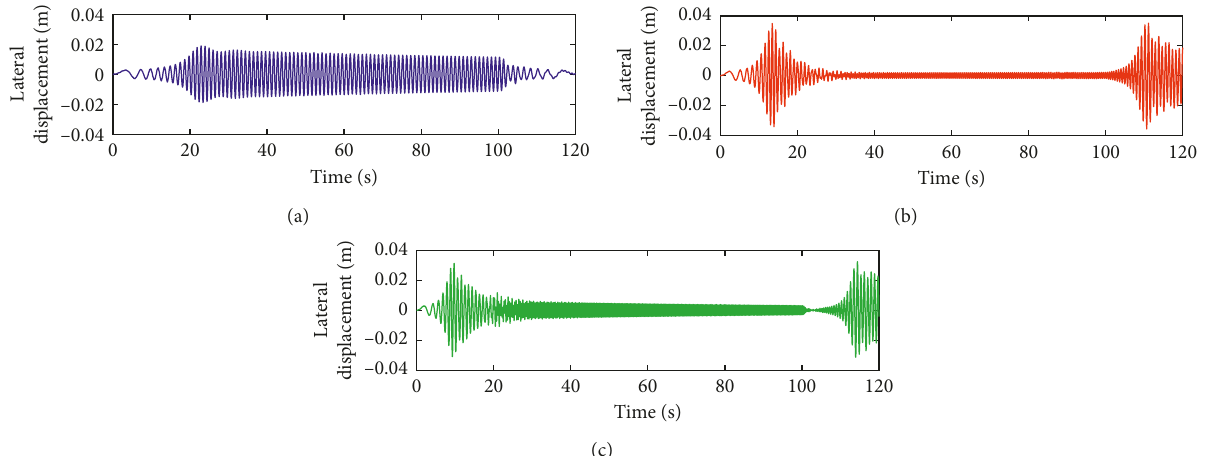
Figure 4: Lateral vibration displacements at l c /2 of the catenary rope in lowering. (a) The first-order excitation, (b) the second-order excitation, and (c) the third-order excitation of head sheave axial